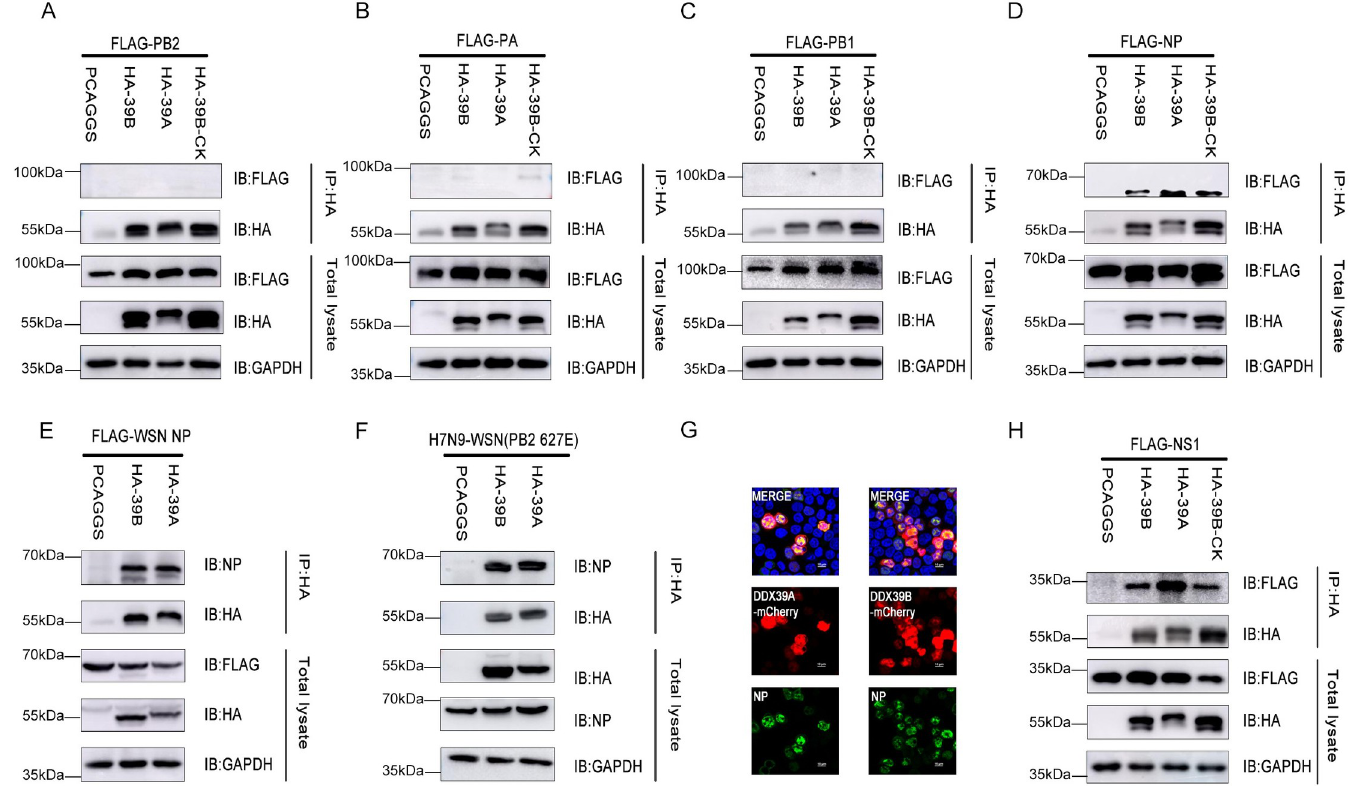
Fig 5. DDX39B and DDX39A interact with NP and NS1 protein. (A, B, C, D and E) HEK293T cells were co-transfected with HA-DDX39B, HA-DDX39A or HA-DDX39B-ck and FlAG-PB2 (A), FlAG-PA (B), FlAG-PB1 (C), FlAG-NP (D) of influenza virus A/Anhui/1/2013 (H7N9) or FlAG-NP of influenza virus A/WSN/ 1933 (H1N1) (E), at 48h after transfection, the cells were lysed, followed by co-IP with anti-HA mouse Mab and western blotting using anti-FlAG mouse Mab and anti- HA mouse MAb. (F) HEK293T cells were transfected with HA-DDX39B or HA-DDX39A, at 24h after transfection, the cells were infected with recombinant influenza virus WSN-H7 627E at MOI = 1. At 24h after infection, the cells were lysed, followed by co-IP with anti-HA mouse Mab and western blotting using anti-NP mouse Mab and anti-HA mouse MAb. (G) DDX39B-mCherry or DDX39A-mCherry together with NP were transfected into HEK293T cells, 24 hours after transfection, the cells were fixed and examined via fluorescence microscopy. (H) HEK293T cells were co-transfected with HA-DDX39B, HA-DDX39A or HA-DDX39B-ck and FLAG-NS1 of influenza virus A/WSN/1933 (H1N1), at 48h after transfection, the cells were lysed, followed by co-IP with anti-HA mouse Mab and western blotting using anti-FlAG mouse Mab and anti-HA mouse